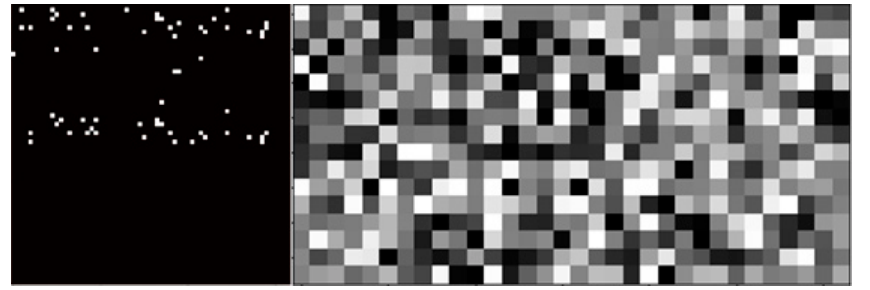
Figure 4. Visualization of vectorized reaction representations. ECFP (left), ECFP + E (LSTM) (right).